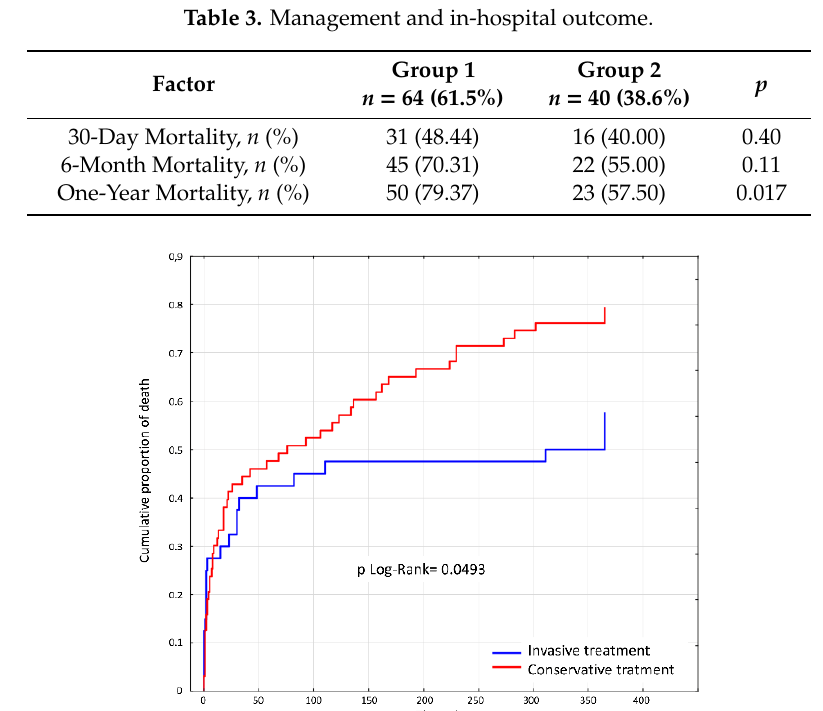
Table 3. Management and in-hospital outcome.